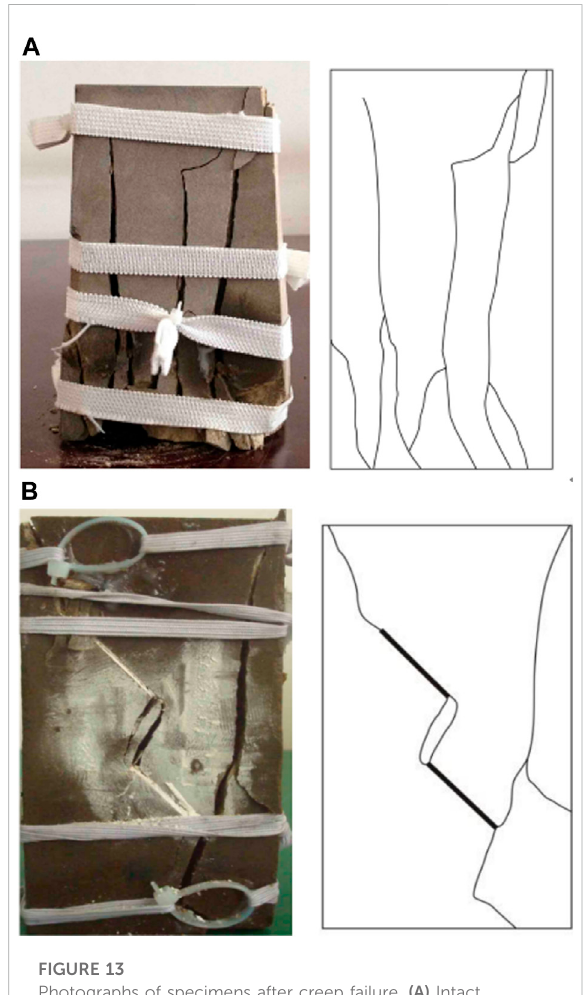
FIGURE 13 Photographs of specimens after creep failure. (A) Intact specimen. (B) Prefabricated fi ssures